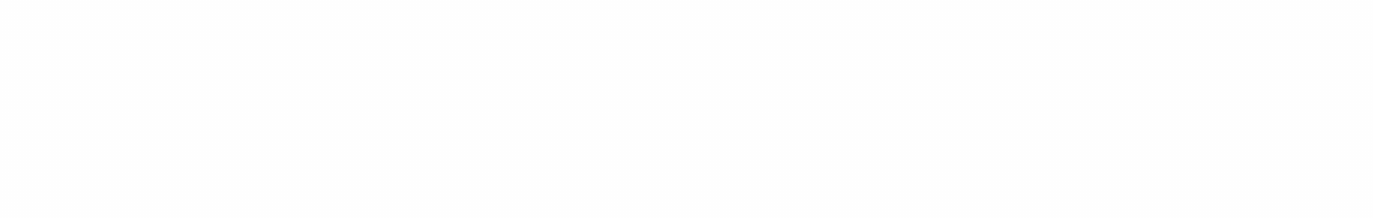
Fig. 6: Mean (+ e.p.m.) perimeter (tm) values for n. Rt levels and II (Top)-, and for OT- levels II and Iii (Bottom)- of control (Control) and detelencephalated groups